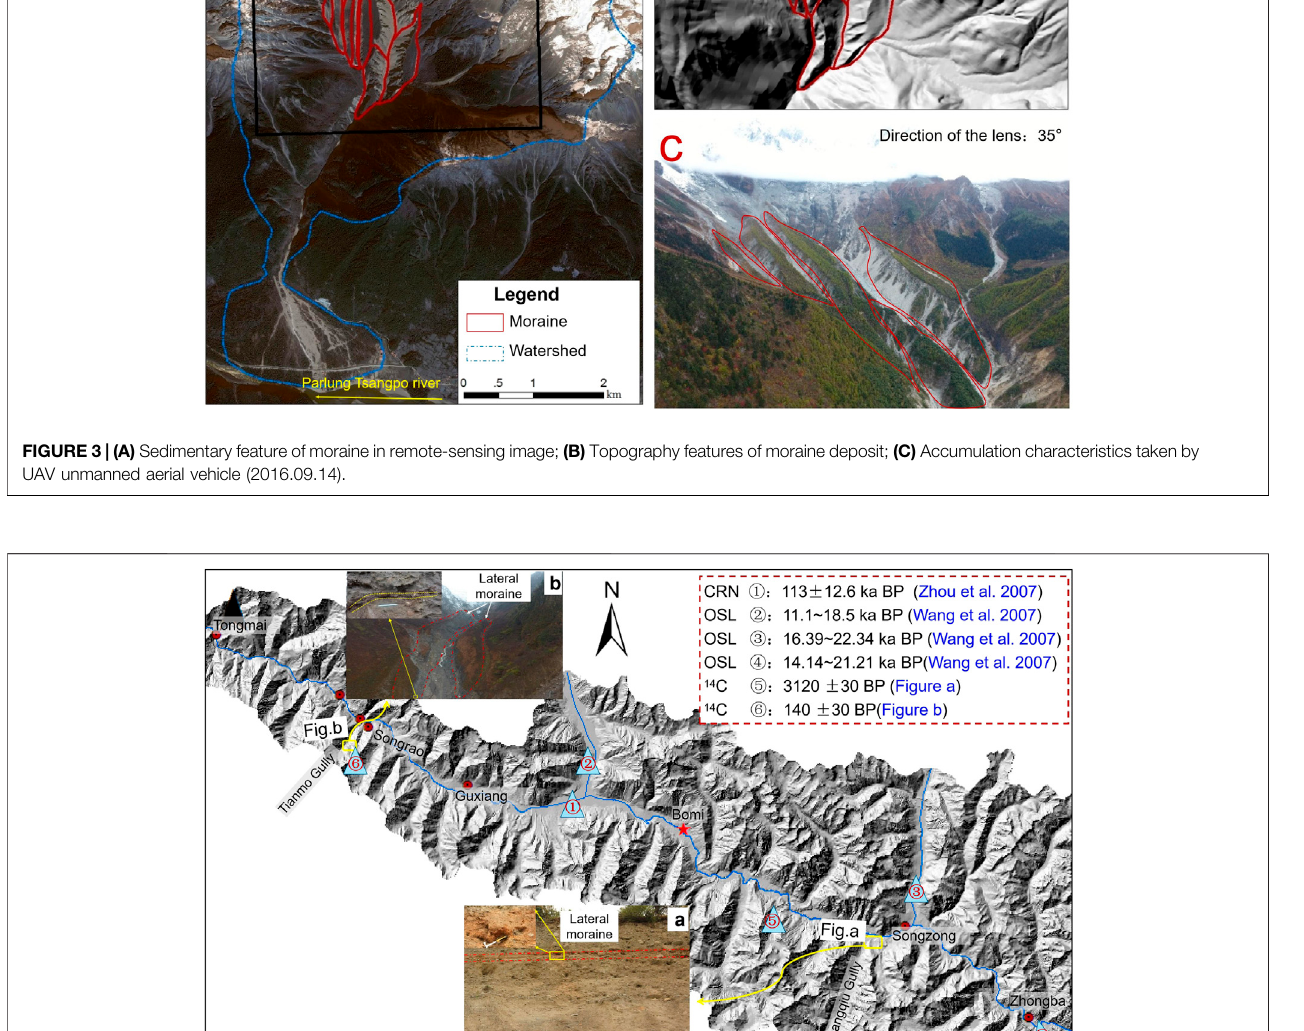
Frontiers in Earth Science |